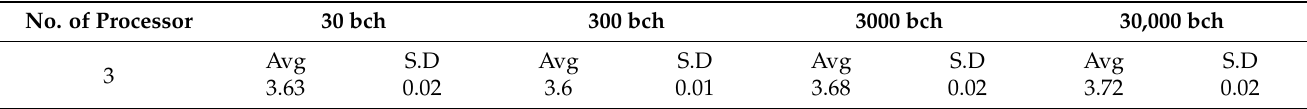
Figure 7. Individual node performance was evaluated using only three processors each. The aver- age value of five average CPU times required to repeat 3 × 10 8 computational simulations for the PDD in a 10 cm × 10 cm field size was analyzed. Table 5. Prior to cluster evaluation, calculations were performed with three processors each to compare individual node performance. Node CPU time (h) is the average of the results of repeating